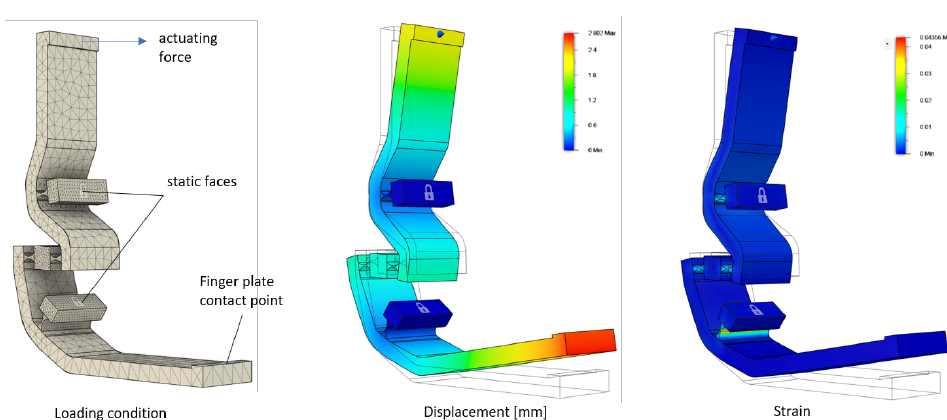
Figure 3. FEM analysis of the flexure hinge mechanism when loaded with finger plate moving in free air at 3 mm moving plate displacement. The thickness of the hinges is 0.1 mm in the shown